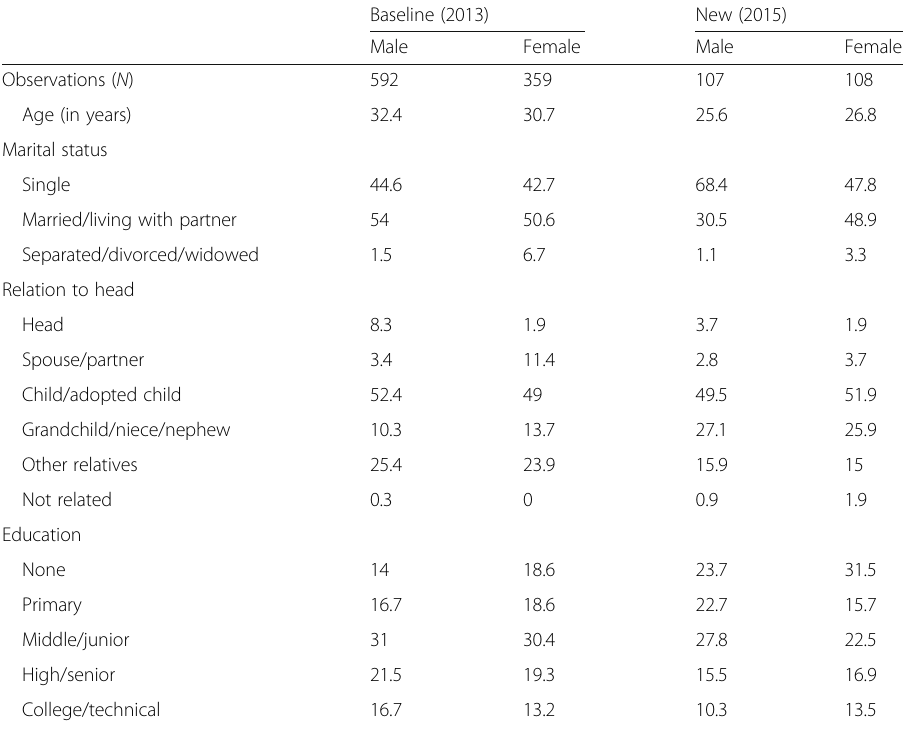
Table 2 Demographic information of migrants, by year and